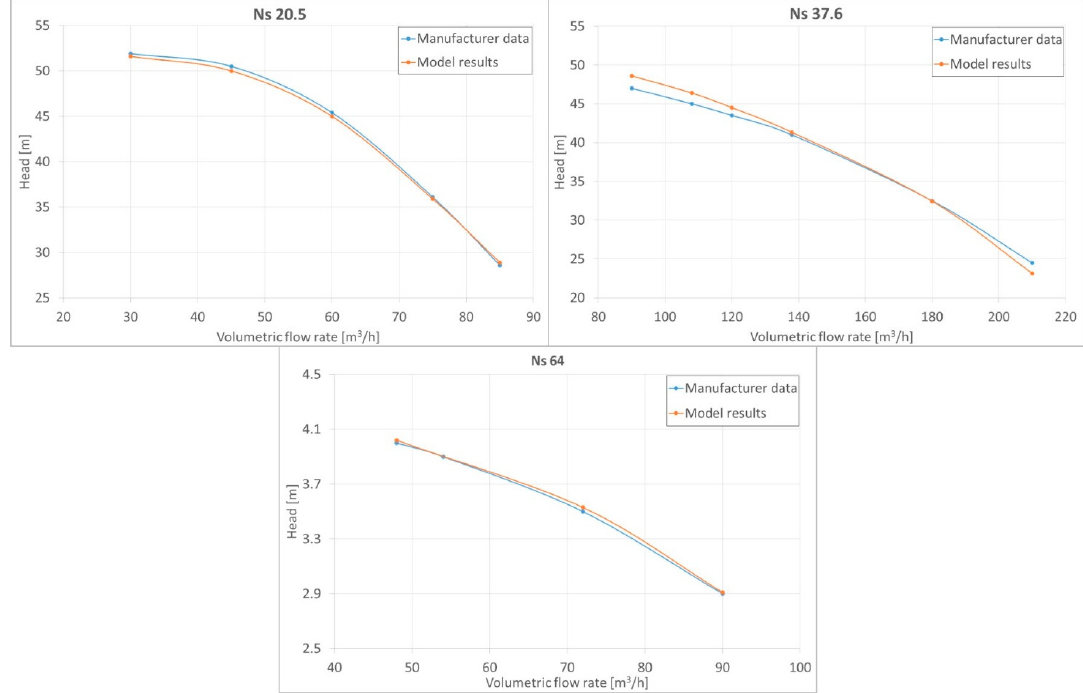
Figure 5. Model validation: Comparison between manufacturer’s data and model results.